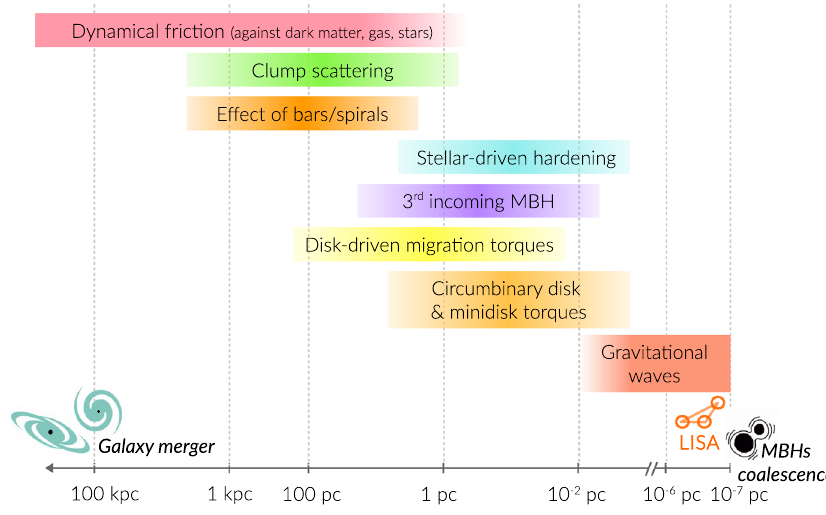
Fig. 17 Illustration of the physical processes affecting two coalescing MBHs after the merger of their host galaxies. The cartoon reports the typical physical scales associated to each process for a nearly equal mass MBH pair of about 10 6 M (cid:3) . Scales vary depending on the exact mass, mass ratio and host galaxy properties. These physical processes are described in Sects. 2.2.1.1, 2.2.1.2 (dynamical friction); Sect. 2.2.1.3 (clump scattering, effect of bars/spirals); Sect. 2.2.2.1 (stellar-driven hardening); Sect. 2.2.2.4 (3rd incoming MBH); Sect. 2.2.2.2 (disc-driven migration torques; circumbinary disc and minidisc